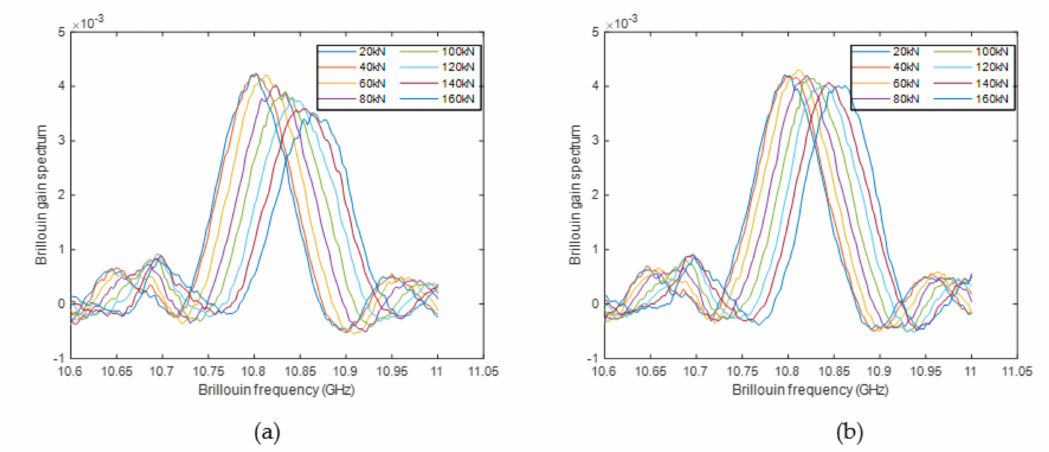
Figure 23. Comparison of BGS under di ff erent load levels ( a ) with crack ( b ) without